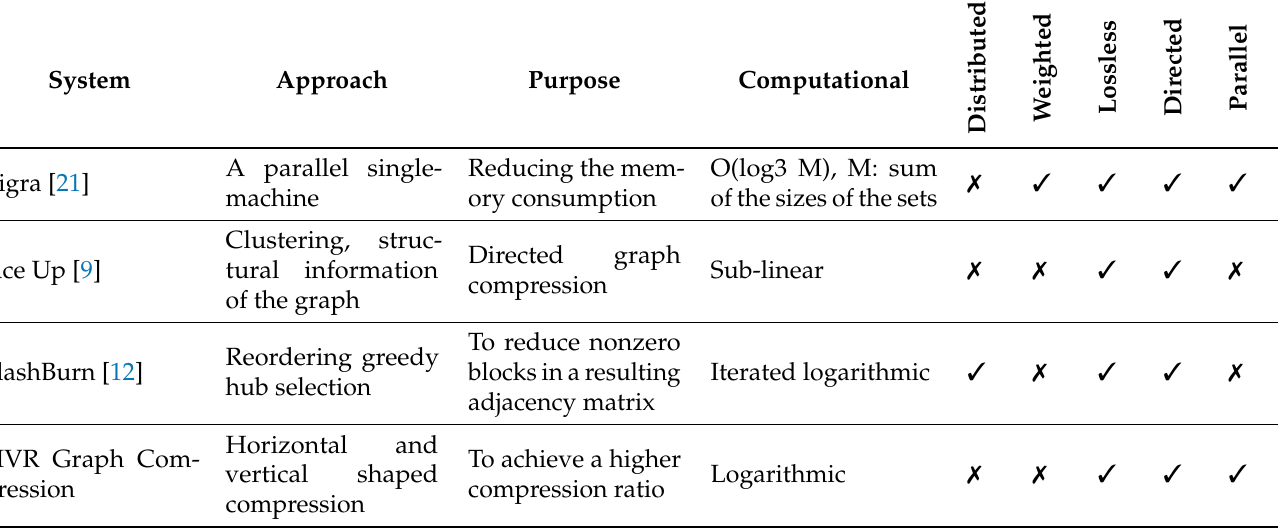
Table 1. A comparison of all the relevant compression techniques based on the properties of the input graph and the features of the algorithm.